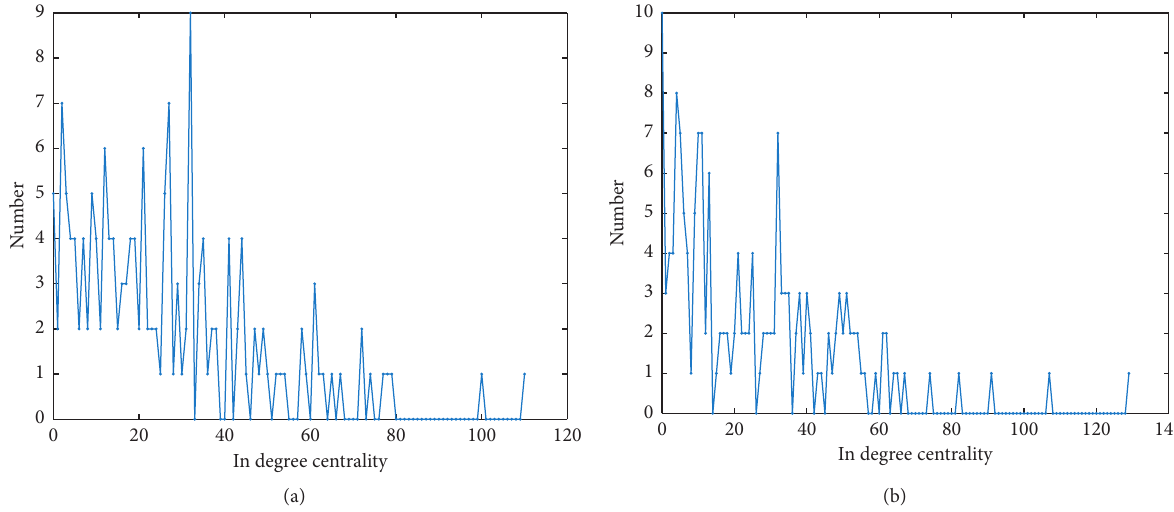
Figure 7: Distribution diagrams of in degree centrality of CSI 300 network in 2016-2017 (a) and 2017-2018